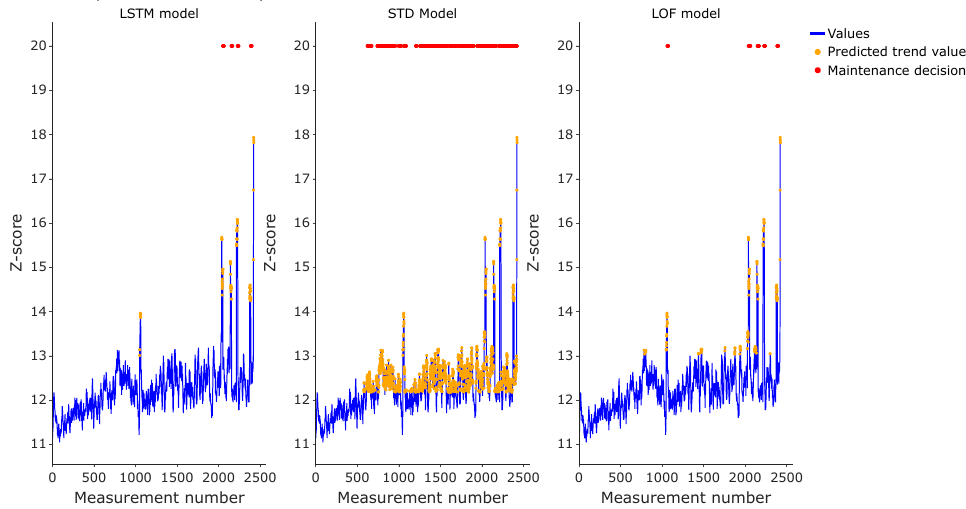
Figure 12. Results of selected anomaly detection models for accelerated wear test 1.